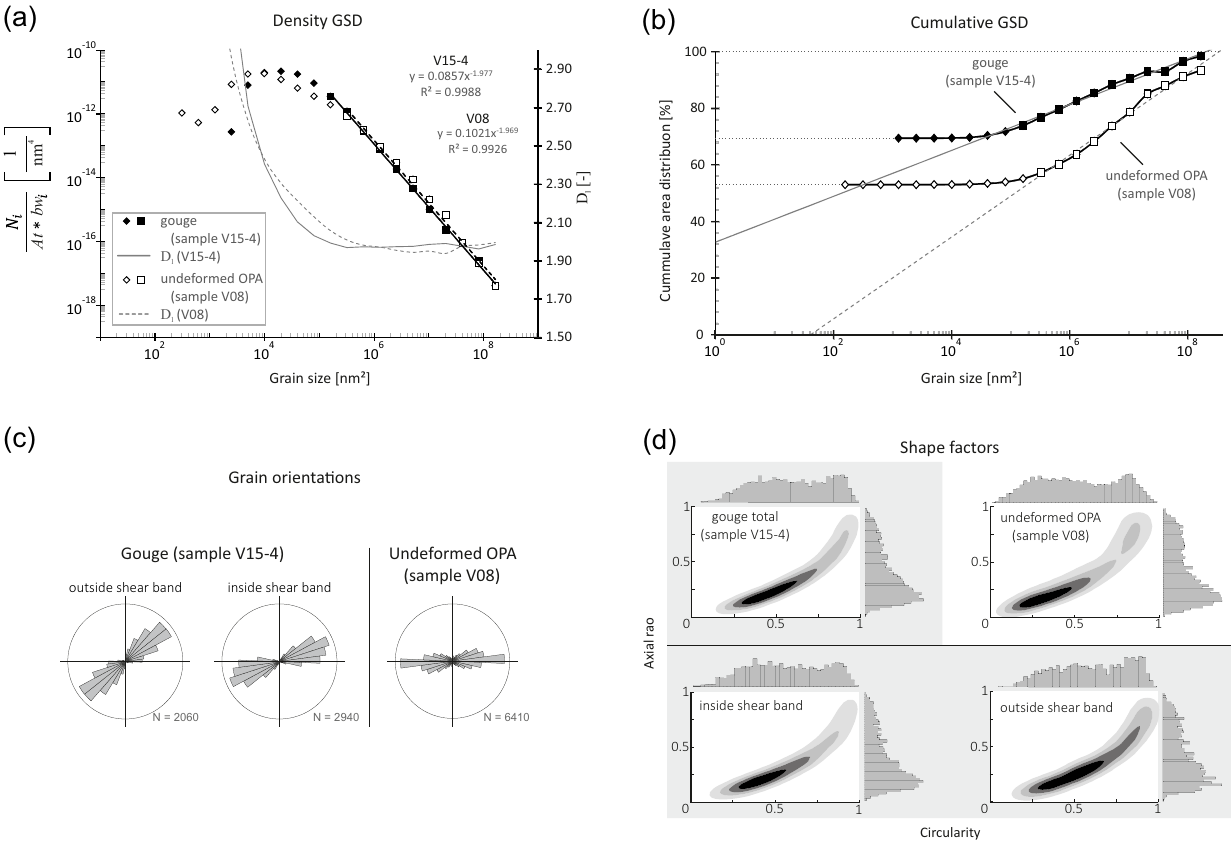
Figure 12. Statistics on grain size, shape and orientation of samples V15-4 (gouge) and V08 (undeformed OPA); see Fig. 11. (a) Density grain size distribution (GSD): grain size vs. number of grains ( N i ) noted with respect to bin width (bw i ) and normalized for the examined area (At); D l : local slope, indicating a deviation from the power-law trend for smaller grain size bins due to resolution limitations (truncation). Boxes: values used in power-law trend calculation; diamonds: values excluded from power-law calculation. Note the parity in density GSD for the undeformed OPA and gouge. (b) Cumulative GSD: grain size vs. cumulative area. Note that the distribution does not sum up to 100% due to excluding (i) pores and (ii) grains that do not fall completely within the examined area. The curves start depending on the matrix content of the samples, i.e., on the area percentage that cannot be visually divided into segments. Note that a strict extrapolation for the cumulative gouge GSD results in unrealistically small grains (less than one lattice plane distance). Hence, a larger contribution of grains below the BIB-SEM resolution limit is inferred. (c) Grain orientations weighted by the grains’ axial ratio. (d) Axial ratio vs. circularity, with the mean center of gouge deviating from the undeformed OPA, indicating an increased smoothness of the gouge grains.